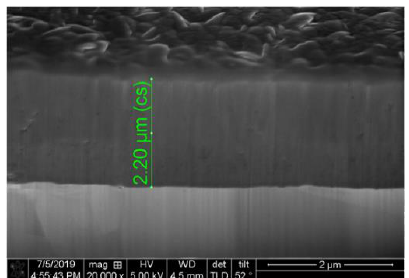
Figure 1. FIB-SEM (Focused Ion beam-scanning electron microscope) fracture morphology of Ti film coating with untreated oxygen-free high-conductivity copper (OFHC) substrate.